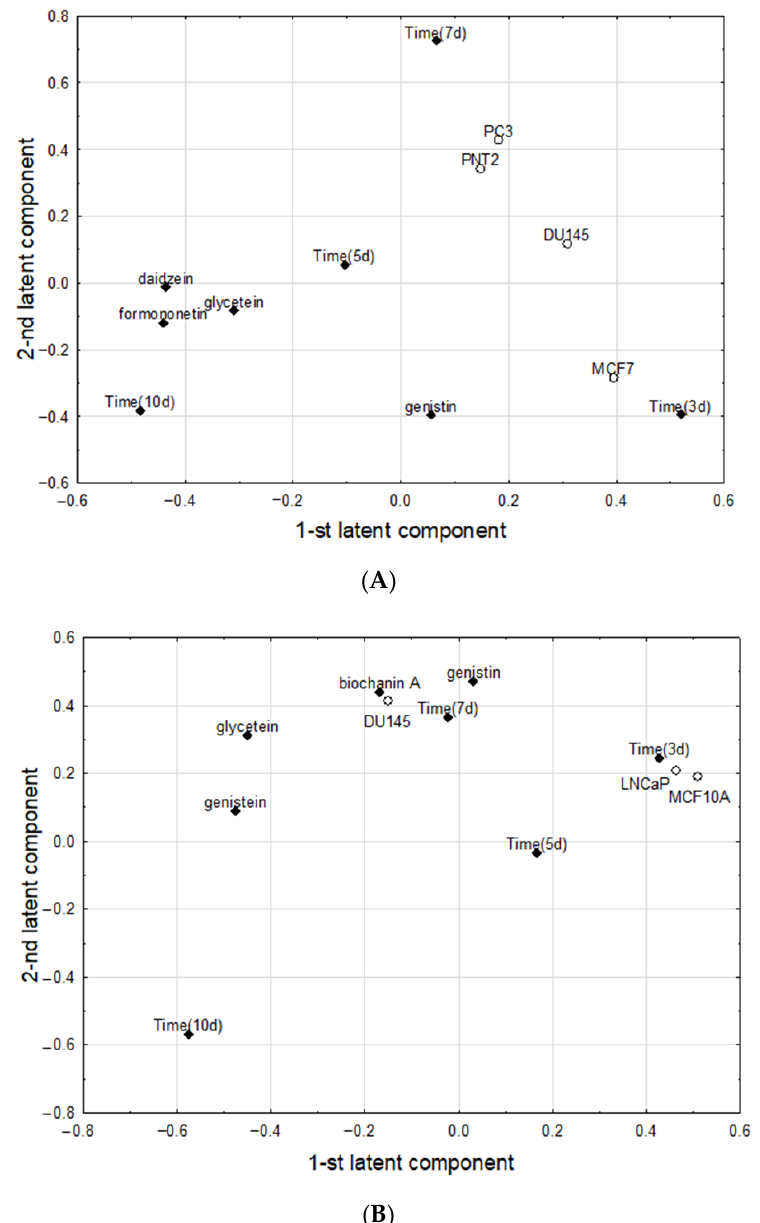
Figure 7. The parameter loadings on first and second latent components in the first PLS model (the predictive parameters are marked with diamonds, and response parameters by circles); ( A ) for chickpea sprouts; ( B ) for lupin sprouts. Time (3d), (5d), (7d), (10d) — sprouts harvested for 3, 5, 7, and 10 days. 10 Table 4. Correlation weights for the pairs of parameters based on the PLS model.